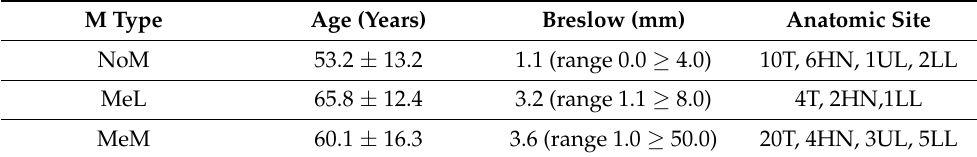
Table 1. Clinical data of melanoma samples—mean age values ± SD, median values with range of Breslow thickness and anatomic site of the lesions (T = trunk, HN = head and neck, UL = upper limb, LL = lower limb).